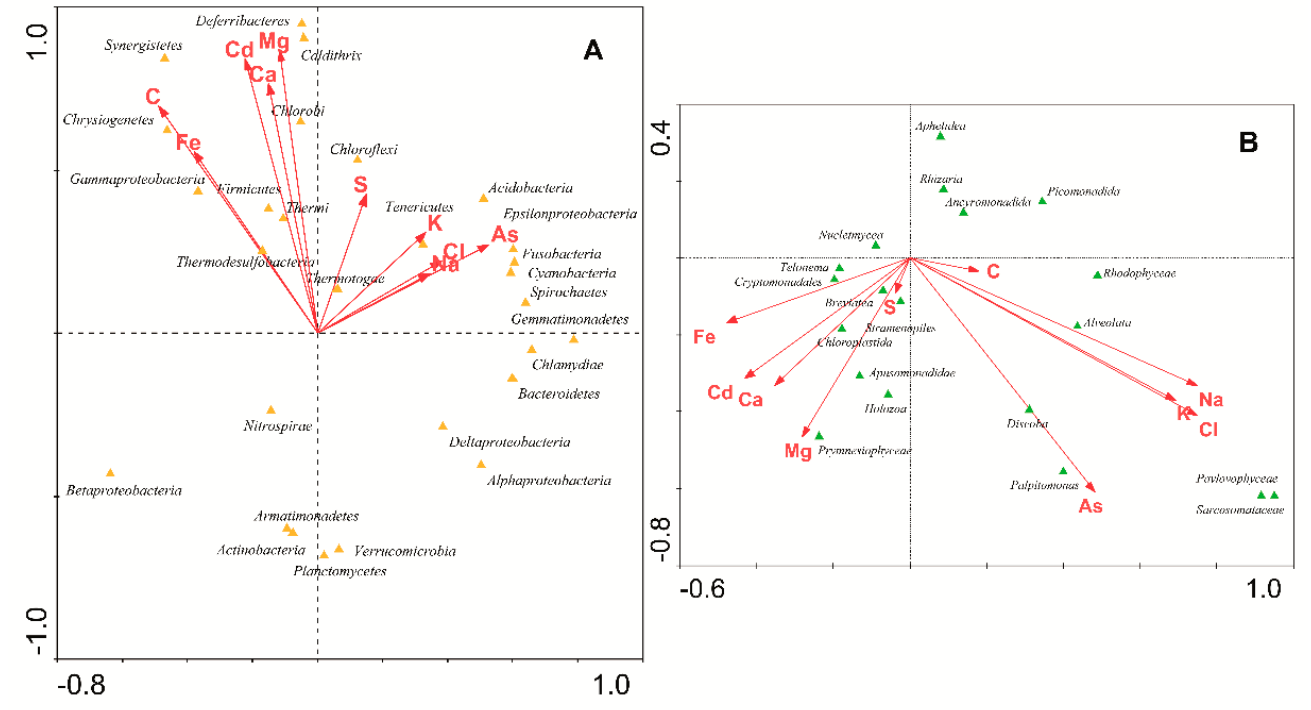
Figure 6. CCA of the microbial phyla of ( A ) bacteria and ( B ) microeukaryotes identified in glaciers with respect to the concentration of main elements (As, C, Ca, Cd, Cl, Fe, K, Mg, Na, S).